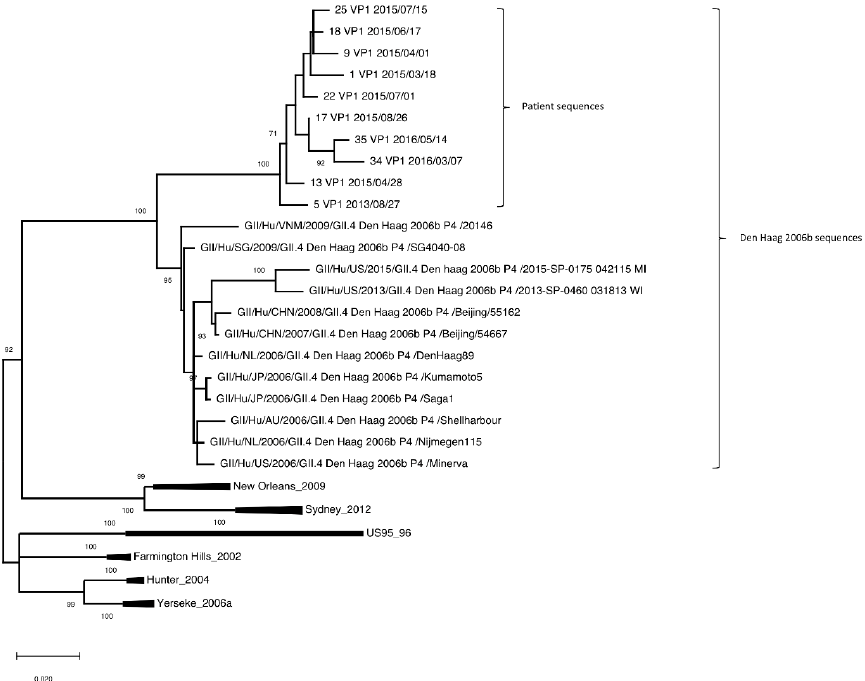
Figure 1. Phylogenetic tree built from VP1 gene of norovirus in the patient samples with reference sequences obtained from NCBI for comparison. Patient samples are designated with Sample-ID, gene name, and date of collection (YYYY/MM/DD). All Den Haag strains used for comparison are shown. Strains within other variants are minimized but can be found in Supplementary Table S1. The RdRp gene was successfully sequenced in 12 samples. Phylogenetic analysis showed that the sequences form a subcluster within Den Haag GII.[P4] (P-type) variant cluster and also shared a most recent common ancestor (MRCA) with a Den Haag variant from 2009 (Figure 2). The obtained nucleotide sequences were compared to known no- rovirus sequences. The sequence from the sample collected in 2013 showed a genetic sim- ilarity of 96.1 – 96.5% compared to the closest known sequences, all GII.[P4] polymerases circulating between 2006 and 2009. Nucleotide identities for sequences from samples col- lected 2015 were 95.4 – 95.7% and for samples collected in 2016, were 95.1 – 95.4%.